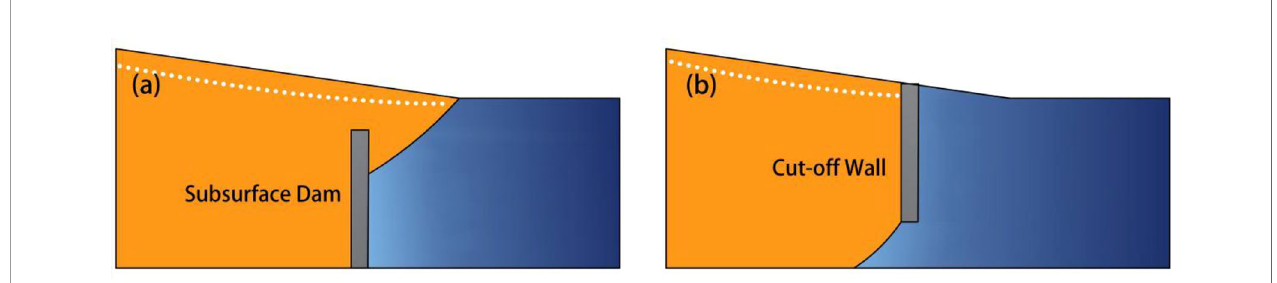
FIGURE 1 | Schematic of a subsurface dam (A) and a cut-off wall (B)